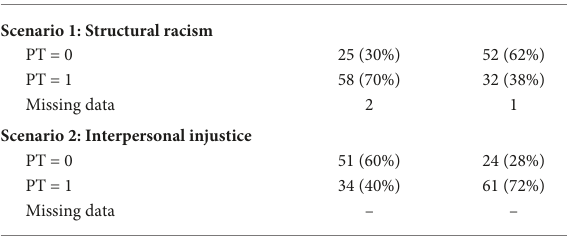
TABLE 3 White participants’ ( N = 85) perspective taking frequency scores for each scenario: Study